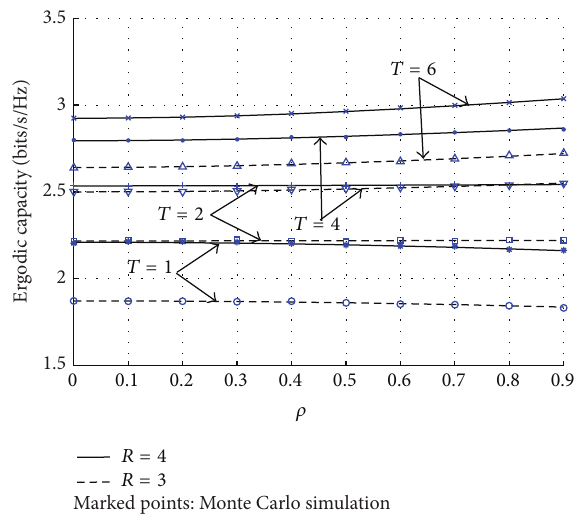
Figure 5: Ergodic capacity versus constant correlation parameter 𝜌 for 𝑅 = 3, 4 ; 𝑇 = 1, 2, 4, 6 . Average SNR per branch is 0